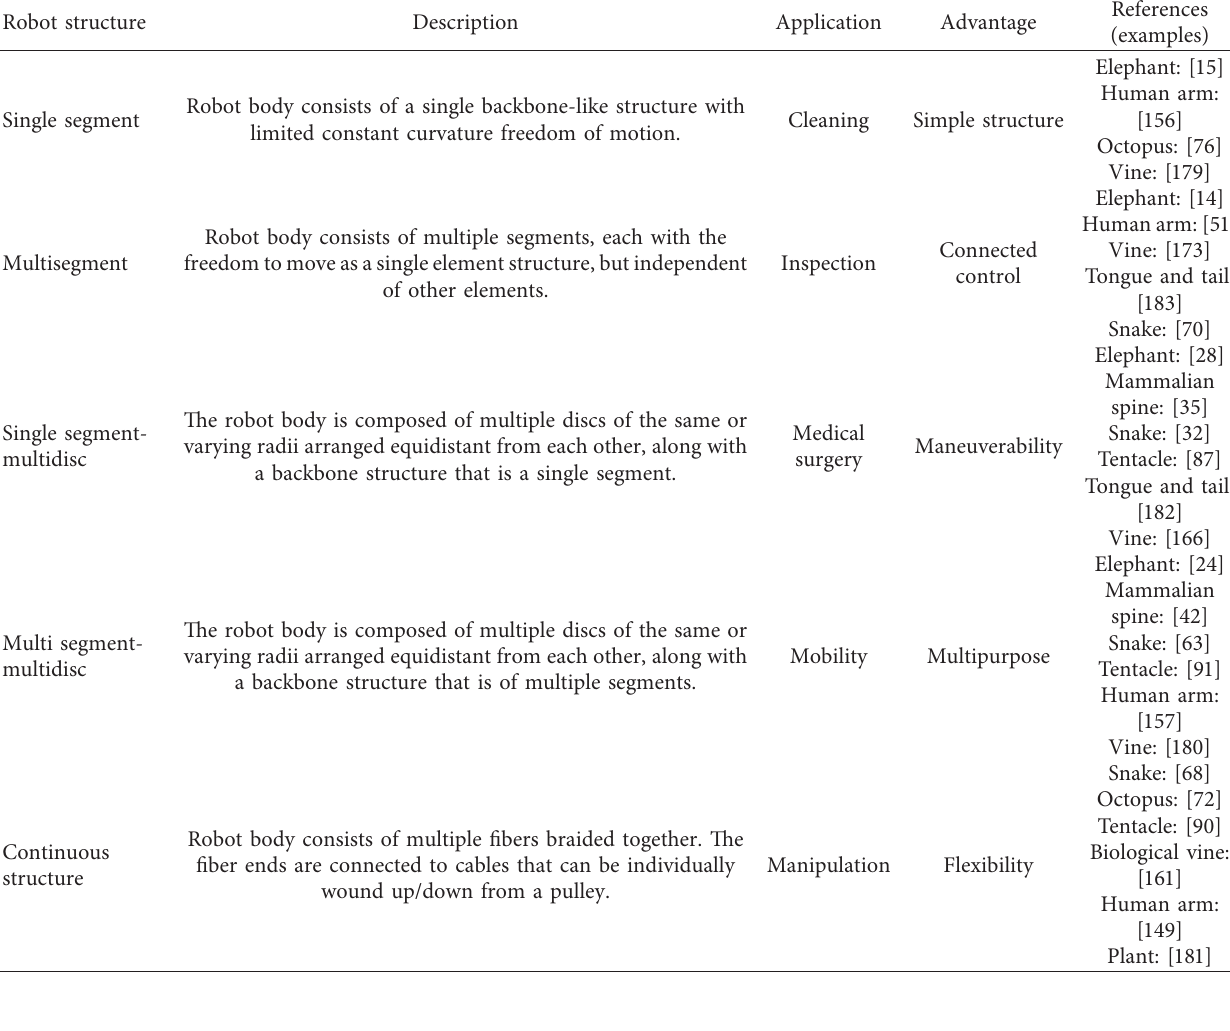
Table 2: The classification of continuum models.